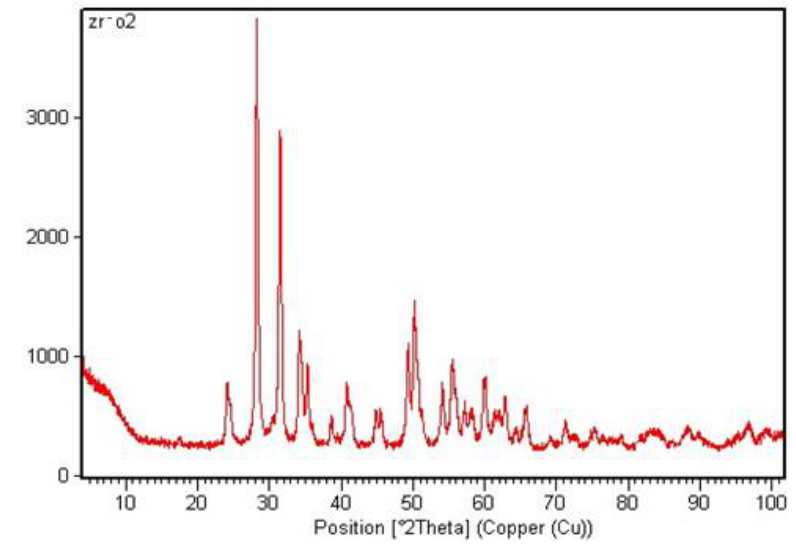
Figure 1. XRD pattern for ZrO 2 nanoparticles.